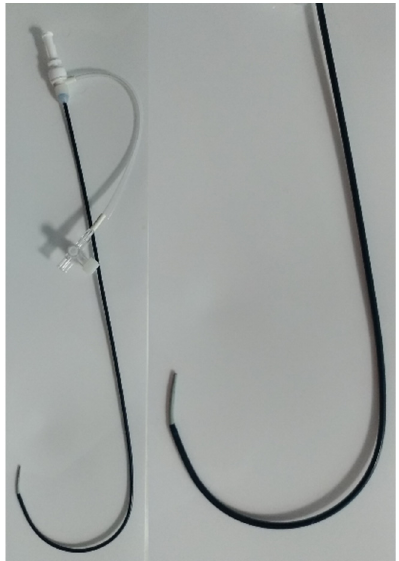
Figure 2. Cook Medical Flexor Balkin Guiding Sheath (5.5 Fr) with Check-Flo Valve and hydrophilic coating. On the right, magnification of the 180° curve guiding sheath.